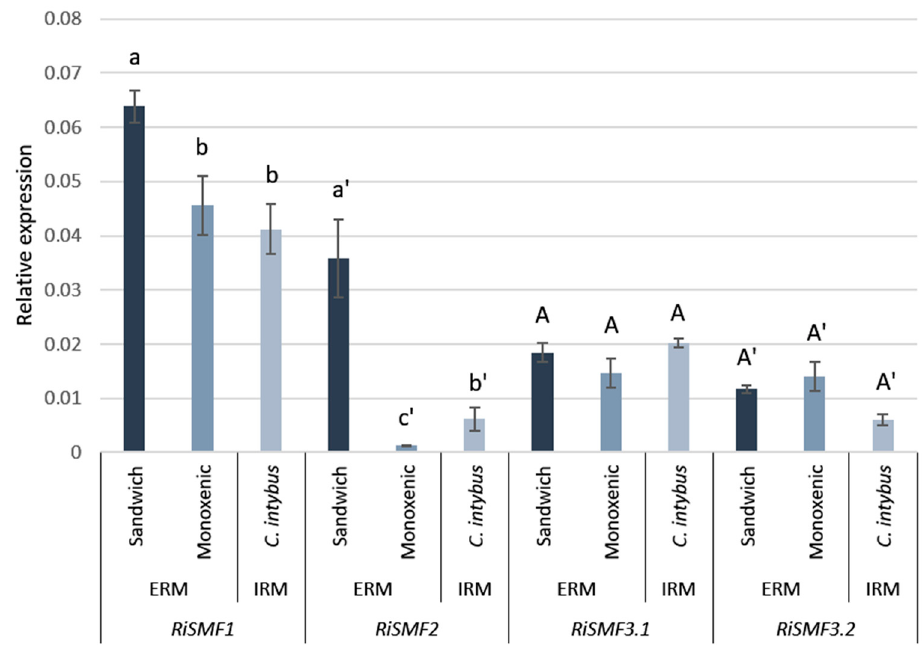
Figure 5. Expression patterns of R. irregularis SMF genes. Gene expression was analysed in RNAs isolated from chicory mycorrhizal roots (IRM), ERM collected in the in vivo whole-plant bidimensional culture system and ERM from monoxenic cultures. Relative gene-expression levels were calculated using the 2 − ∆ CT method, with RiEF1 α as internal control. Bars represent standard error. Different letter types indicate statistical data for each gene. Different letters indicate significant differences ( p < 0.05; n = 3) between treatments.